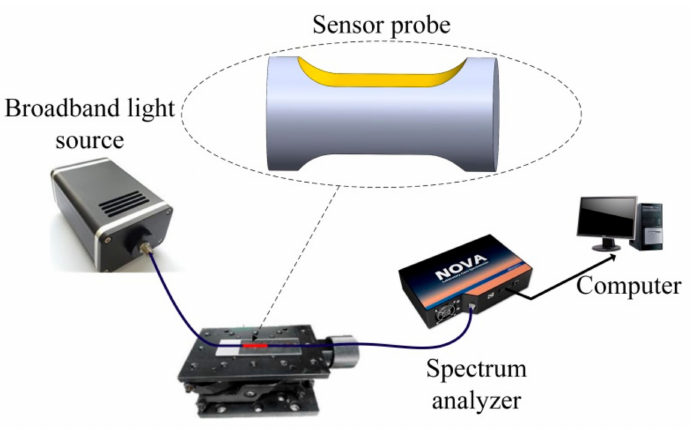
Figure 7. The schematic illustration of the experiment